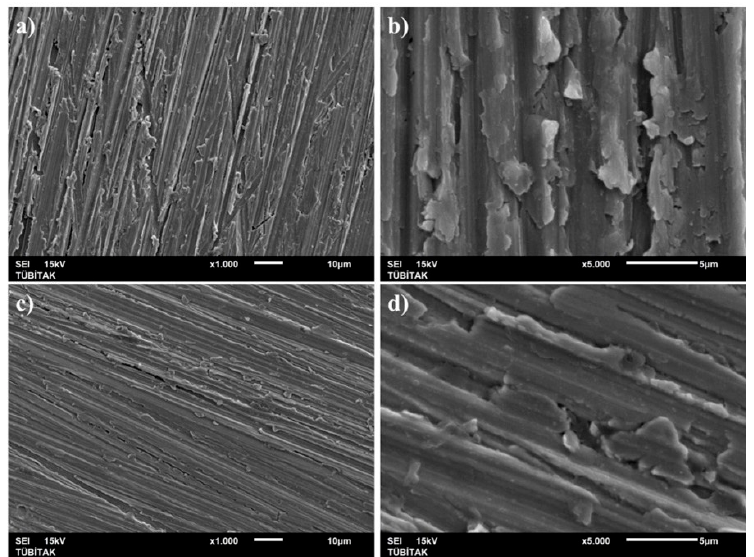
Figure 9. Potentiometric polarization curves of the Cu–10Sn cold-sprayed coatings in 3.5 wt % NaCl (alkaline) and 0.01 M Na 2 SO 4 (acidic) electrolyte solutions at room temperature.